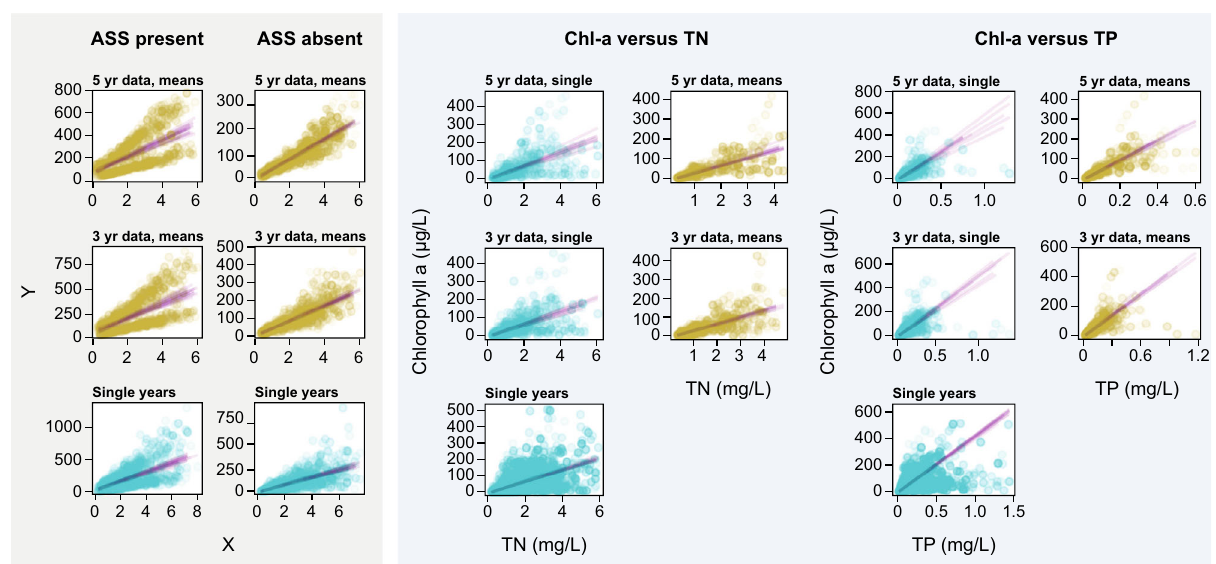
Fig. 2 | Scatter plots of the results of simulated data with and without alter- native equilibria. There is an increasing temporal scale: from single-year obser- vations to 3-year means and then 5-year means for the simulated data in the two panels on the left. Scatter plots of the TN and TP relationship with chlorophyll-a from real-world data with the different temporal perspectives of single-year data, 3-yearmeans and 5-yearmeans. The data were sampled 1000 times iteratively(see methods) for each given time period and a model was derived from each of the